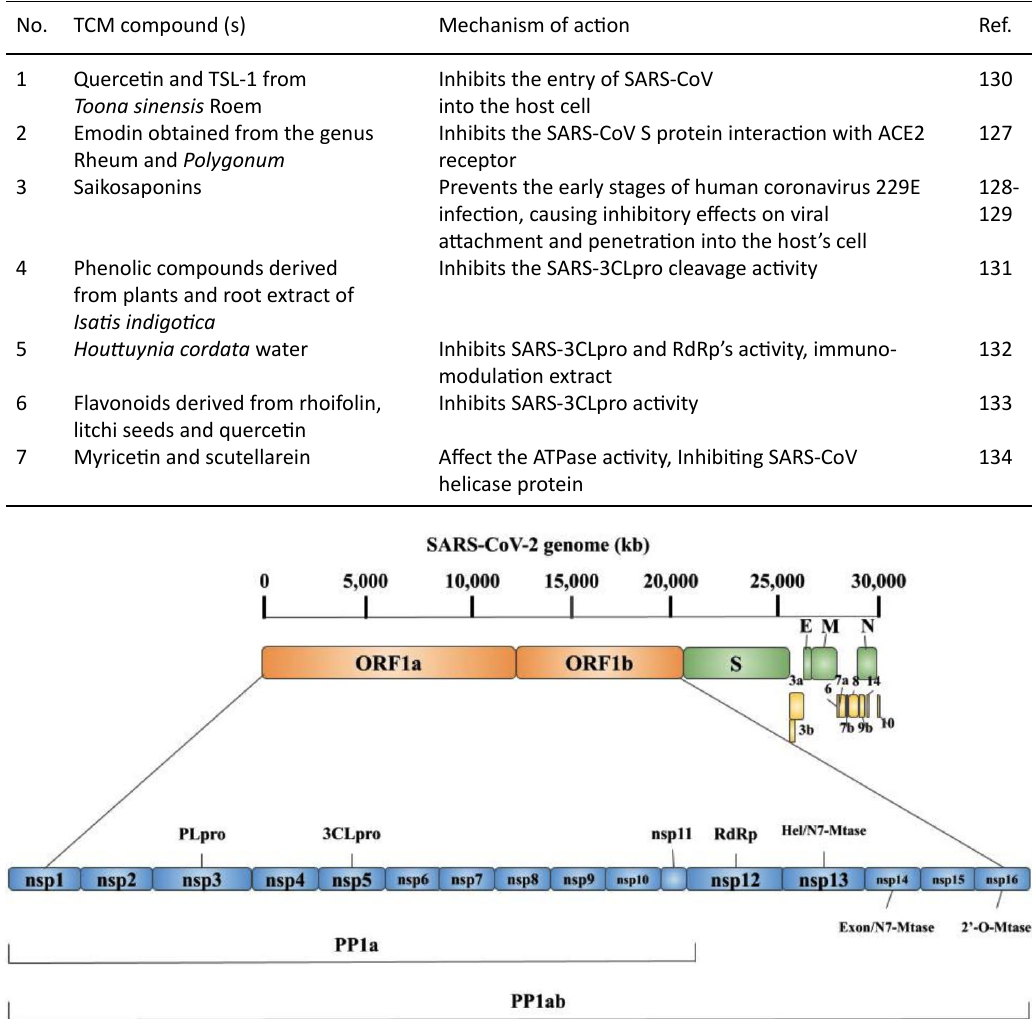
Fig. 2. Genomic Structure of